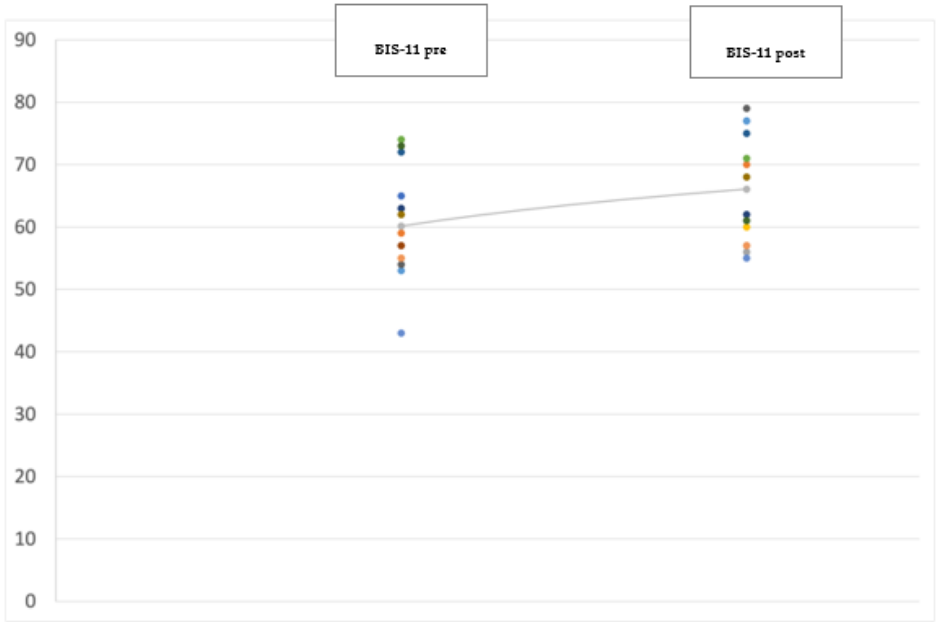
Figure 3. Jittered scattered plot showing the preoperative ( left ) and postoperative ( right ) physio- logical anxiety subscore of the Hamilton Anxiety Rating Scale. The difference between the preoper- ative ONmed and postoperative ONstim showed a p -value = 0.001. The line shows the negative (improving) trend of the values.